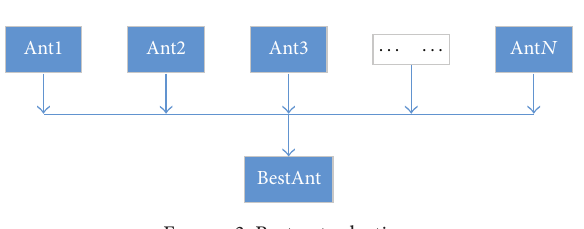
Figure 3: Best ant